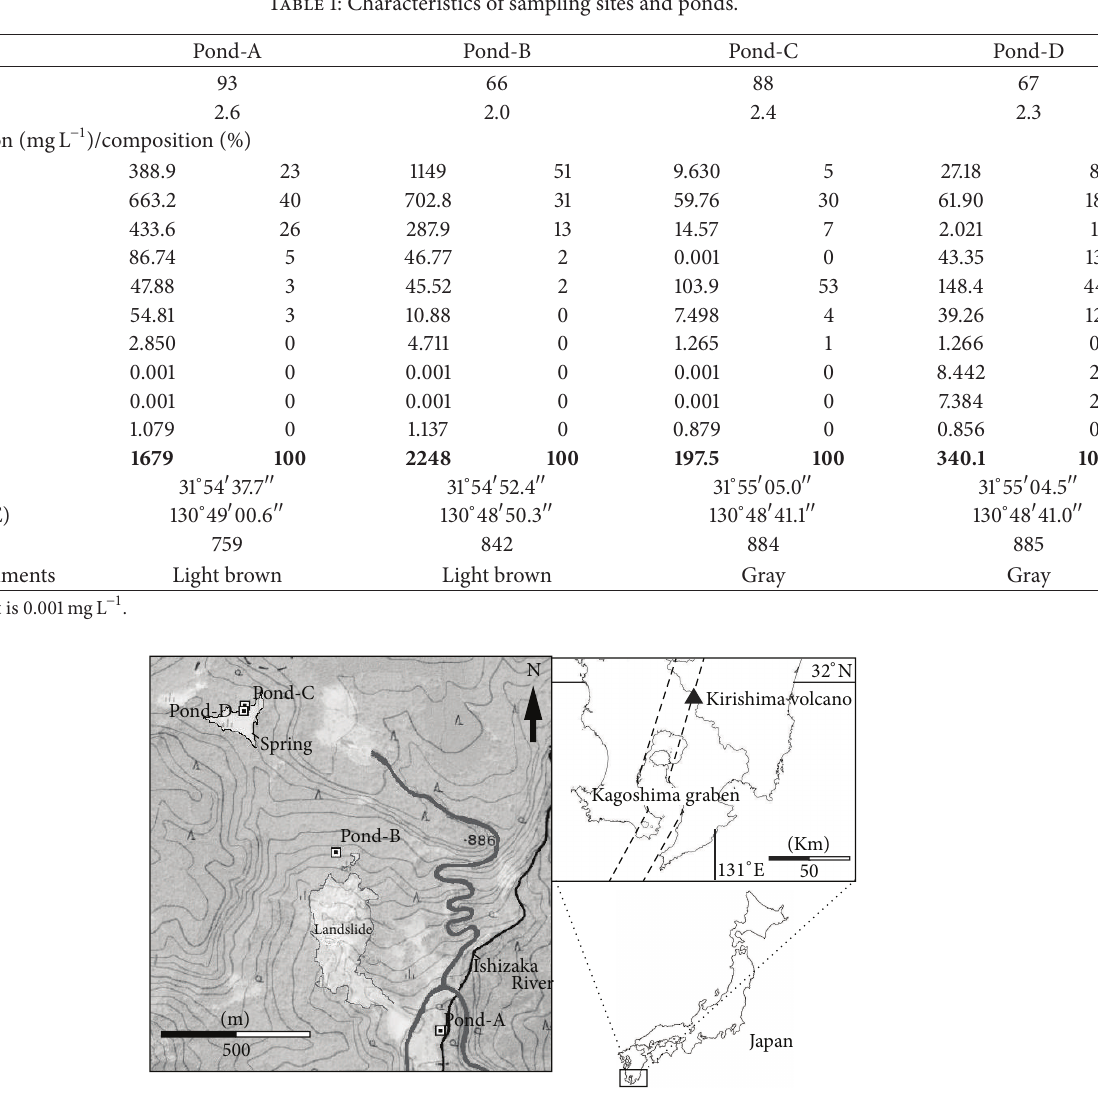
Figure 1: Map of sampling site in Kirishima geothermal area,